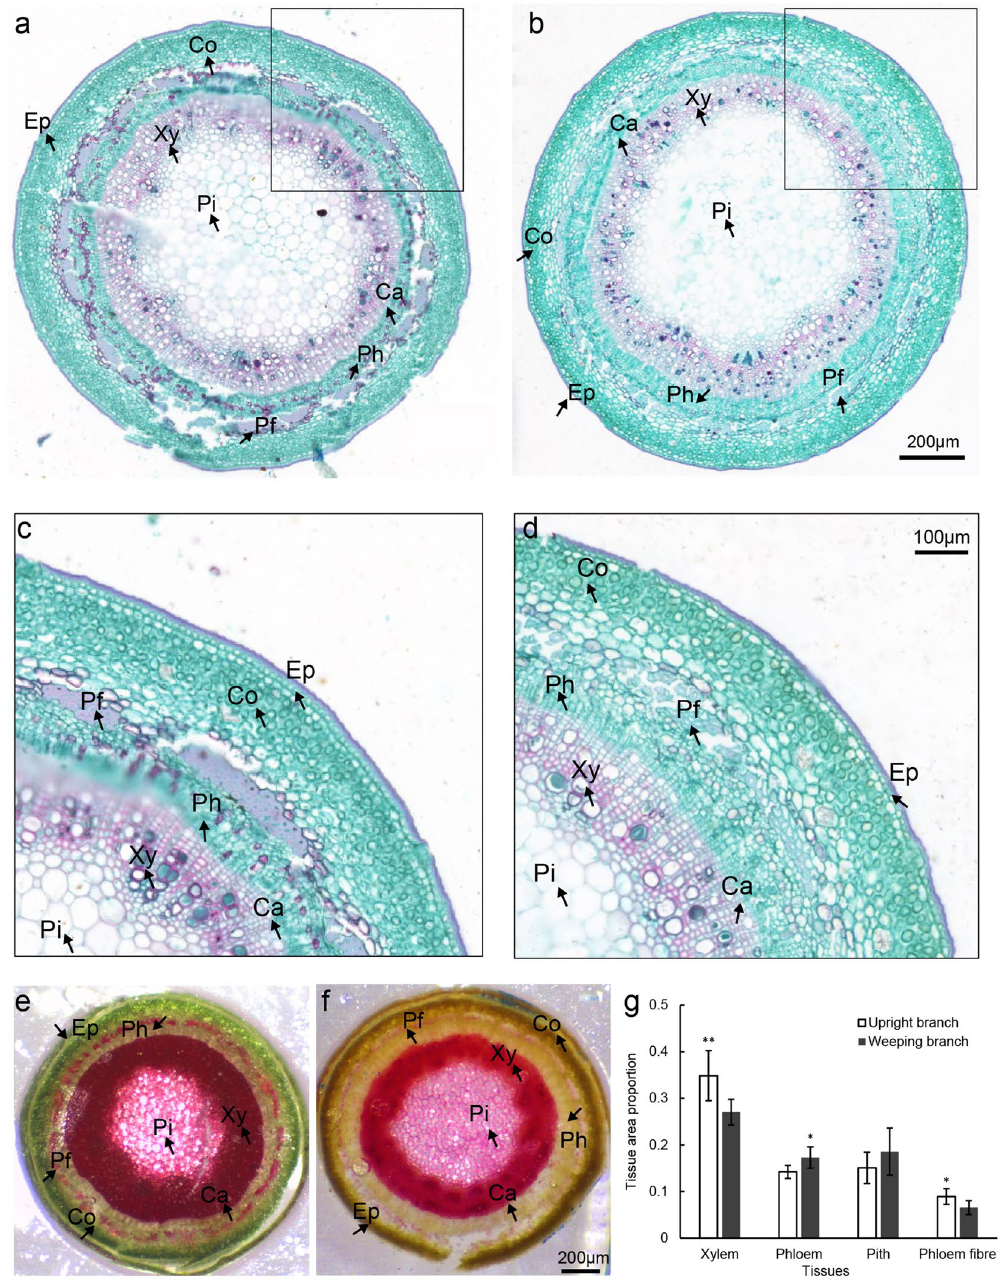
Figure 2. Histochemical characteristics of upright and weeping stems of P. mume . ( a ) Cross-section of elongating annual stems with the upright trait; ( b ) Cross-section of elongating annual shoots with the weeping trait; ( c ) Enlargement of the section in the black box of a ; ( d ) Enlargement of the section in the black box of b ; ( e ) Phloroglucinol-HCL staining of the middle segment of upright stem; ( f ) Phloroglucinol-HCL staining of the middle segment of weep stem; ( g ) The area ratios of xylem, phloem, pith, and phloem fibre tissues to cross-sectional area in the middle of elongating annual upright and weeping stems. Single and double asterisks represent P < 0.05 and P < 0.01, respectively. Error bars represent one standard error of the mean (n = 3). Ep, epidermal cell; Co, cortex; Ph, phloem; Pf, phloem fibre; Xy, xylem; Pi,